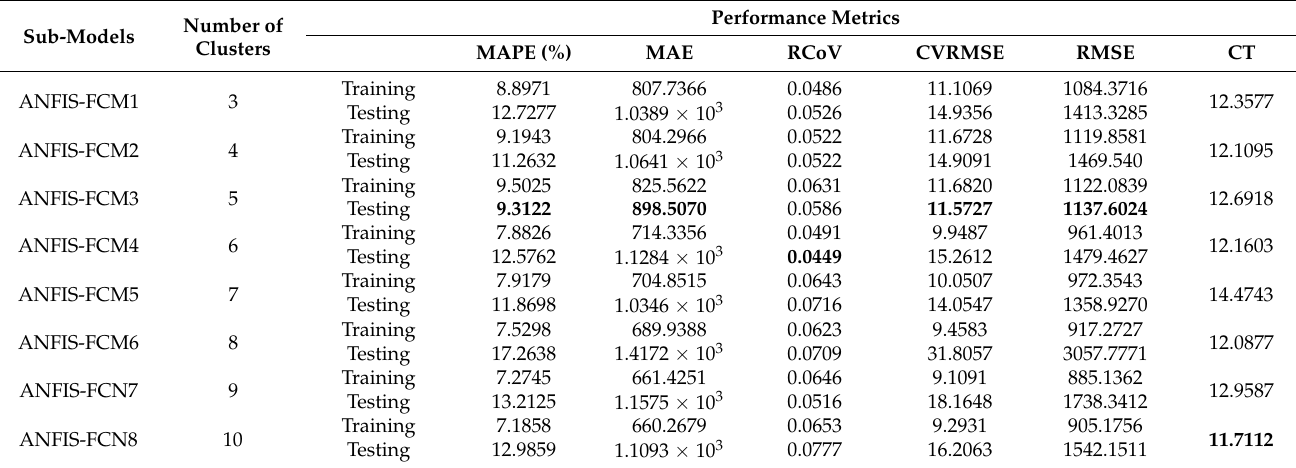
Table 6. Performance analysis for ANFIS-FCM